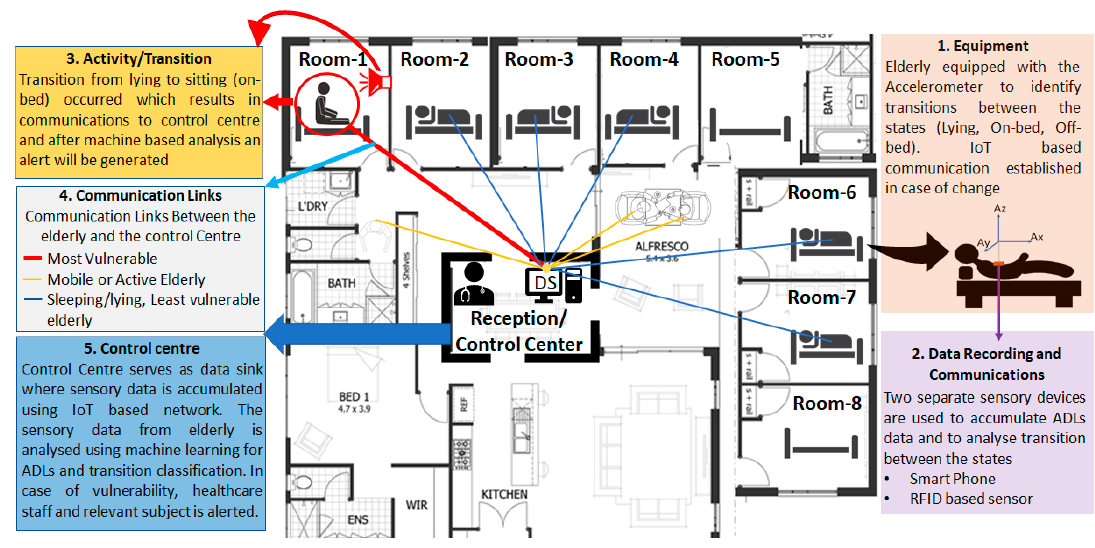
Figure 1. IoT-based patients’ bed-exit monitoring paradigm.